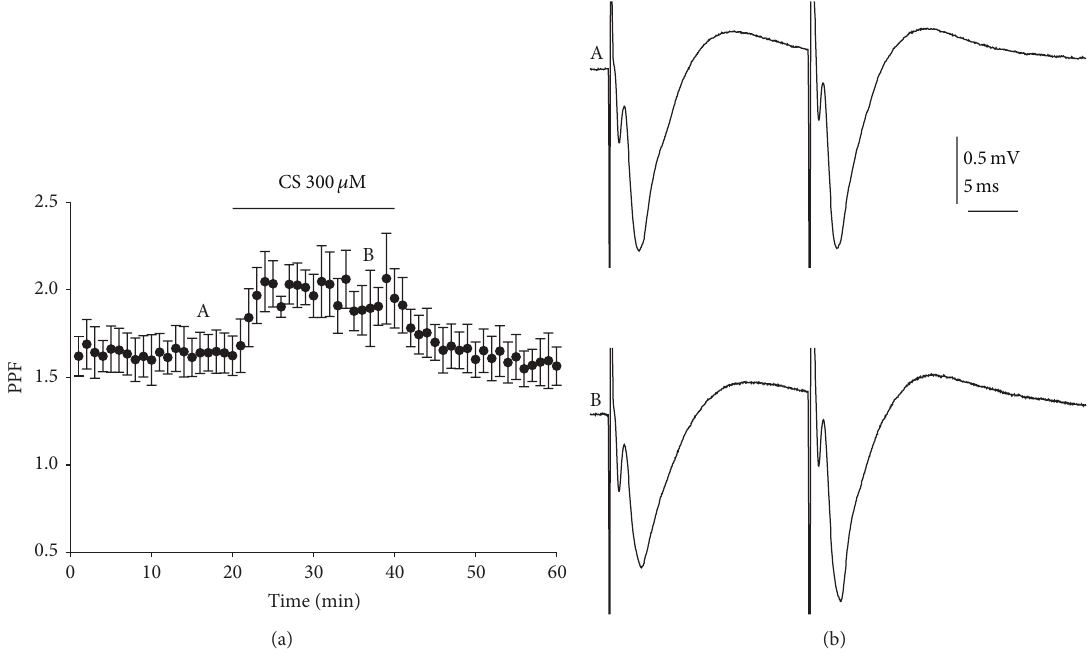
Figure 3: Presynaptic effect of chondroitin sulfate. (a) Time-course of averaged facilitation of fEPSP evoked by paired pulses at 50ms intervals and applied every 15s. Note the facilitation exerted by CS (300 𝜇 M) applied during the time indicated by the top horizontal bar. (b) Representative fEPSPs recorded in response to paired stimuli separated by 50 interpulse intervals in control A and after 20 min of CS (300 𝜇 M) application B. The amplitudes evoked correspond to the 40–50% of maximal response. Data are mean ± SEM of 14 slices